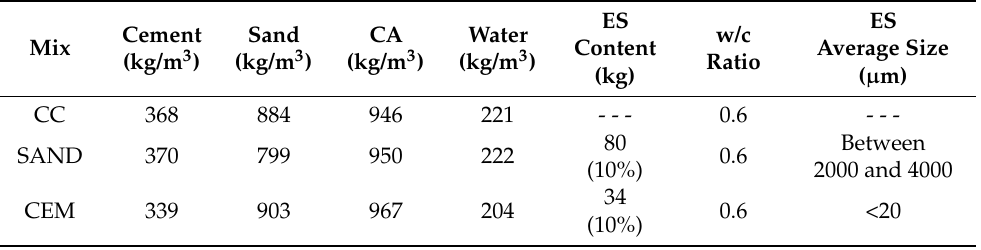
Table 1. The concrete mix proportions (CC = 1:2.4:2.57) using distinct ES particle contents replacing the sand and cement